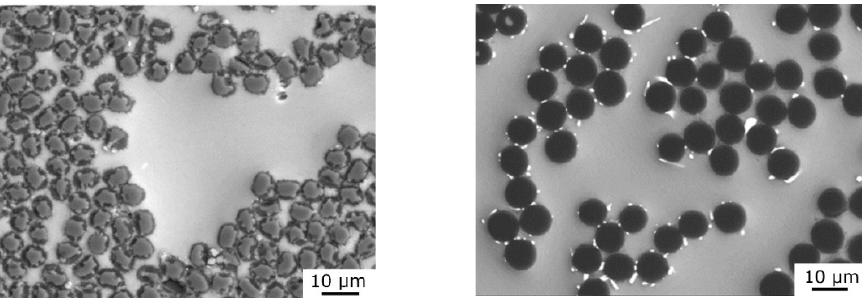
Figure 4. Typical microstructure of the Mg1.8Y/T300 ( left ) and Mg1.8Y/Granoc ( right ) composites.